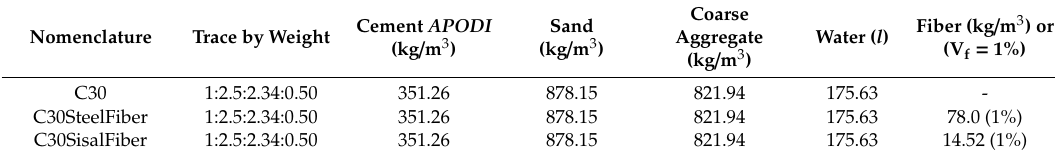
Table 4. Dosage used in the experimental procedure for 1 m 3 of